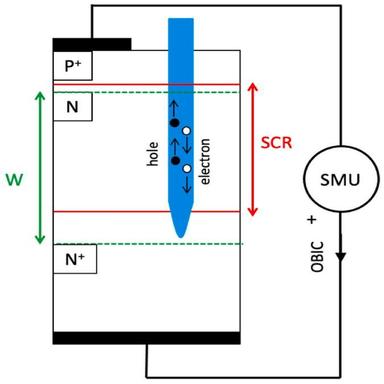
Plane-parallel infinite PN junction reverse biased by an SMU (Source Measurement Unit). The n-epilayer's thickness is represented by W, and the borders of the space charge region (SCR) are shown in red.